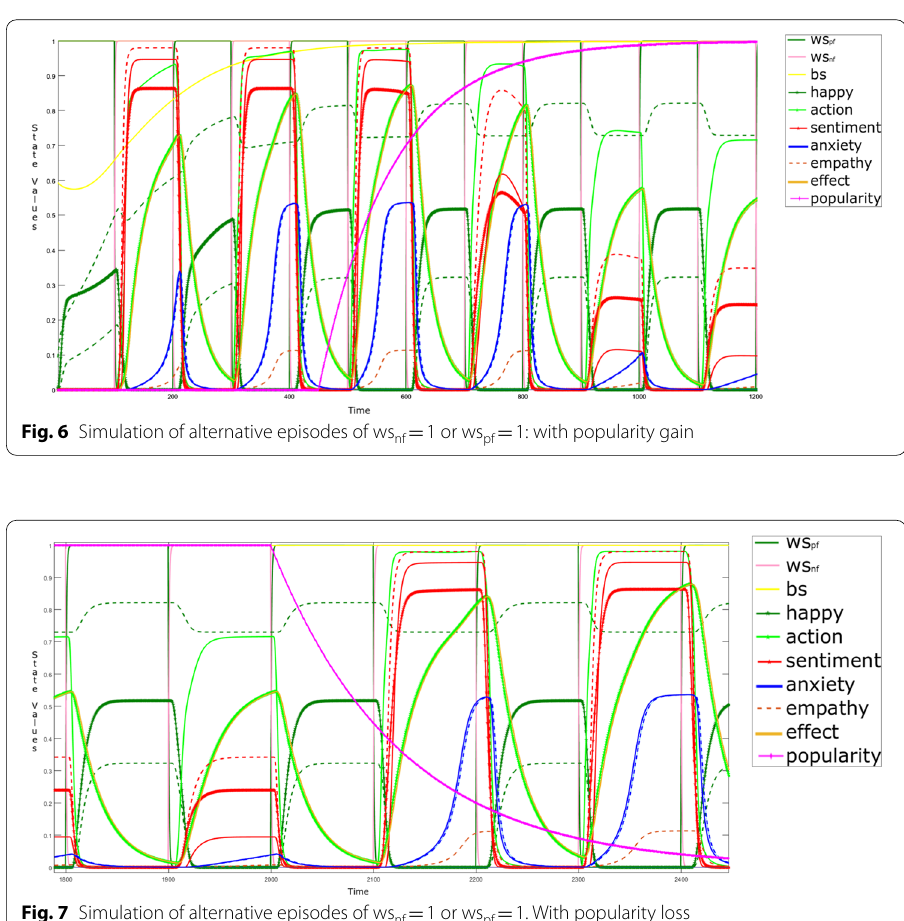
1 or ws pf 1. With popularity = =